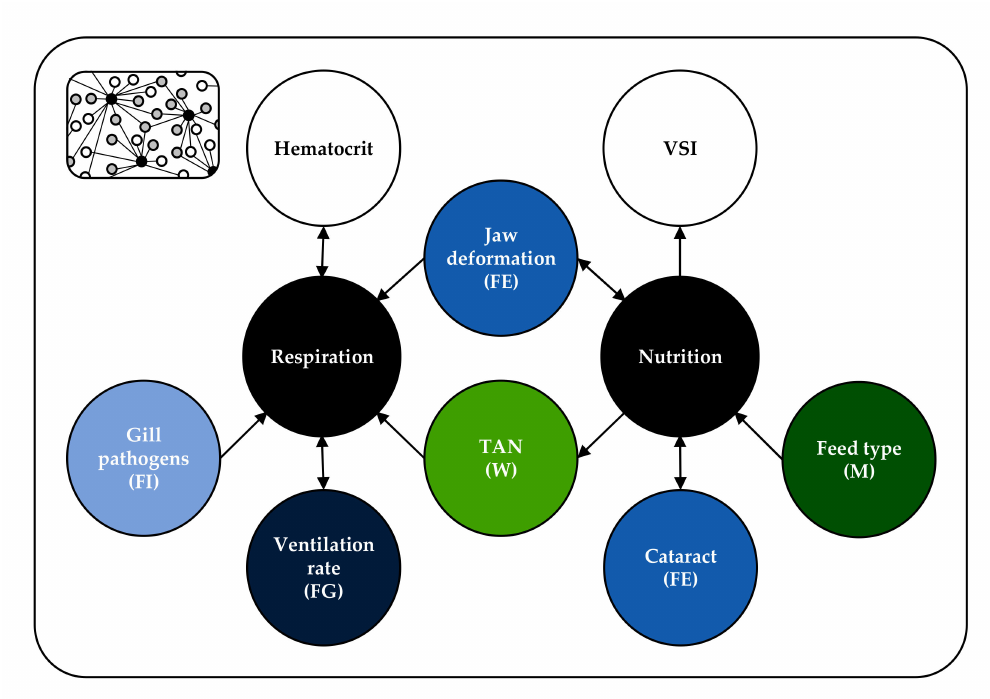
Figure 2. The figure represents a part of the fish welfare ontology that in total consisted of 14 needs, over 200 parameters and their relationships. The needs respiration and nutrition (black) with some of their associated parameters are shown here. The parameters given in colour fulfil the three criteria of being relevant, practicable and reliable, and hence are included in the modules of the model. The parameters in white are neither practicable on-farm nor relevant in the context of this model and therefore are not included. M (dark green) = module farm management, W (light green) = module water quality, FG (dark blue) = module fish group behaviour, FE (blue) = module fish external appearance, FI (light blue) = module fish internal appearance, TAN = total ammonia nitrogen, VSI = viscerosomatic